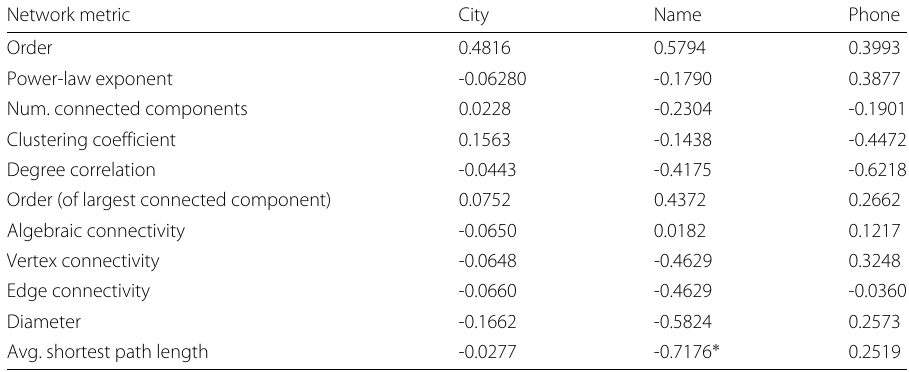
Table 7 Pearson correlation coefficients between recall and network metrics Network metric